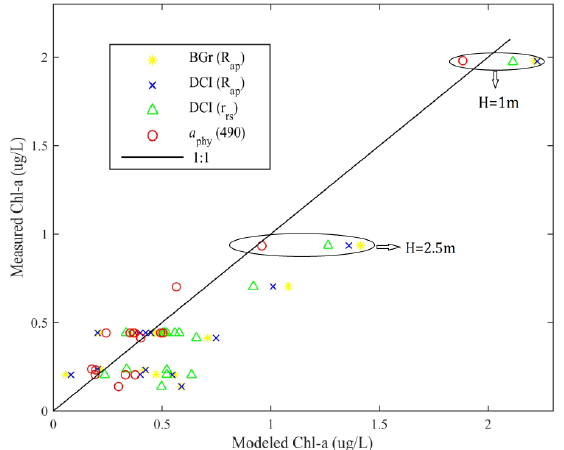
Figure 11. Scatterplots of the Chl-a concentration as a function of ( a ) a phy (490) calculated by r rs (490) and r rs (560), and ( b ) a phy (660) calculated by r rs (560) and r rs (660). RMSE, root mean square error.